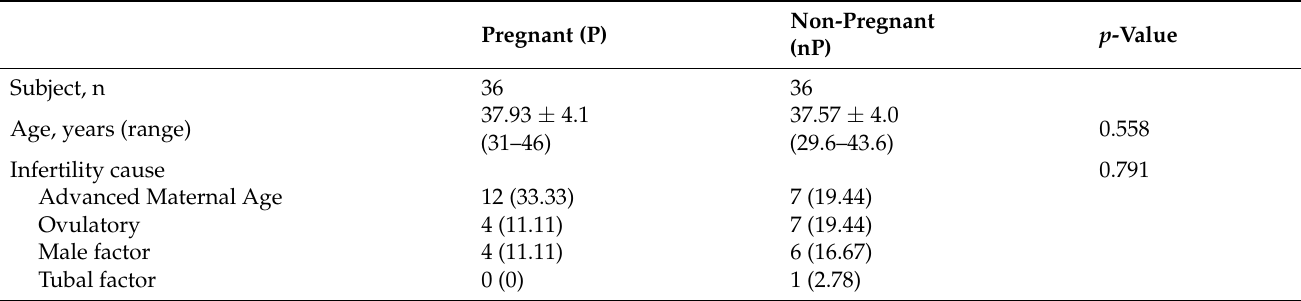
Table 2. Demographic characteristics of all clinical samples determined via qMSP.